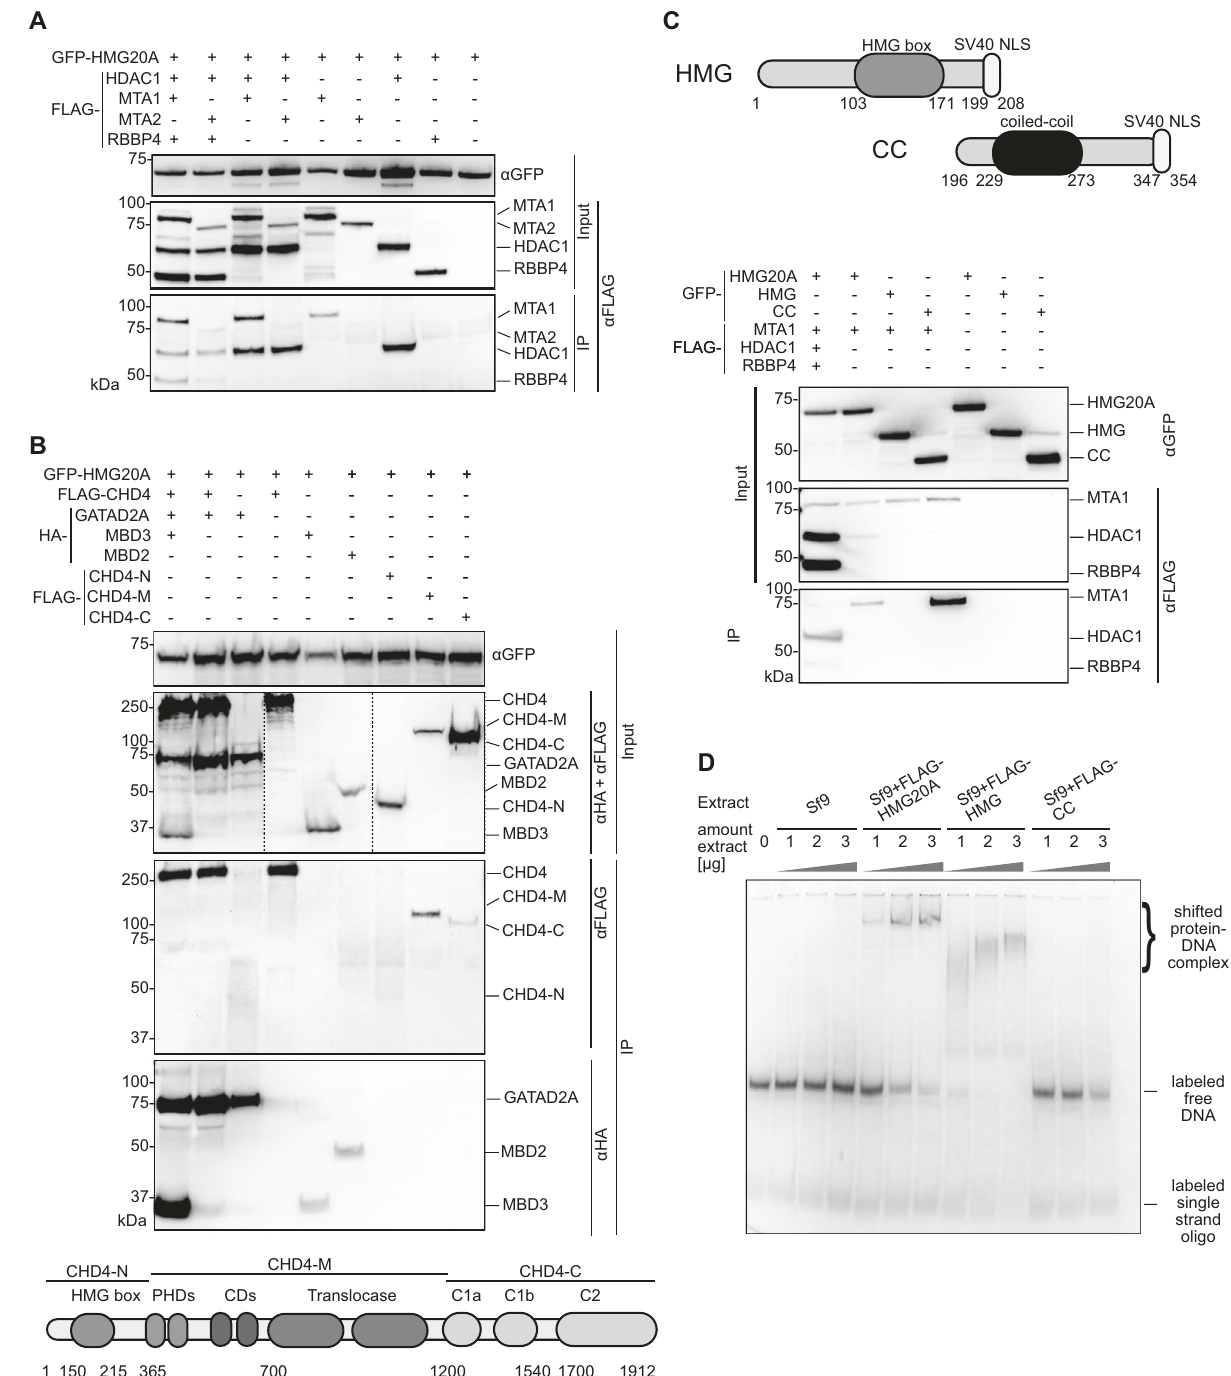
Fig. 2 | HMG20A binds NuRD complex components and DNA. A Anti-GFP immunoprecipitations of HEK293 cell extracts co-transfected with GFP-HMG20A and FLAG-HDAC1, -MTA1, -MTA2 and -RBBP4. Proteins were detected with anti- FLAGoranti-GFPantibodies. B Top:Anti-GFPimmunoprecipitationsofHEK293cell extracts co-transfected with GFP-HMG20A and FLAG-CHD4 (CHD4), -CHD4-N-ter- minus (CHD4-N), -CHD4-middle domain (CHD4-M), -CHD4-C-terminus (CHD4-C) and HA-GATAD2A, -MBD2 and -MBD3. Proteins were detected with anti-FLAG and anti-HA or anti-GFP antibodies. Bottom: schematic depiction of CHD4 deletion